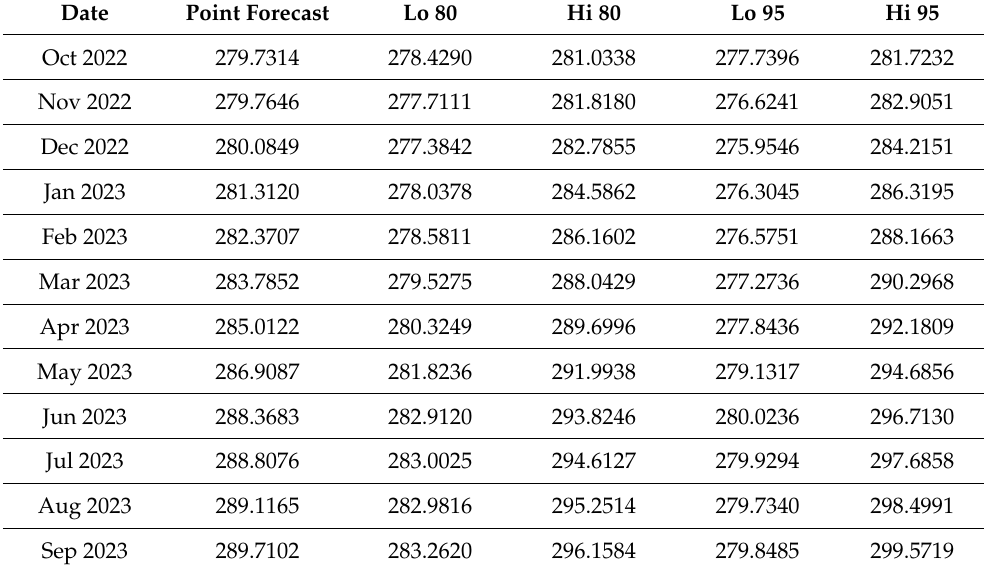
Table A3. Predicted CPI trend in Chicago. Own processing.